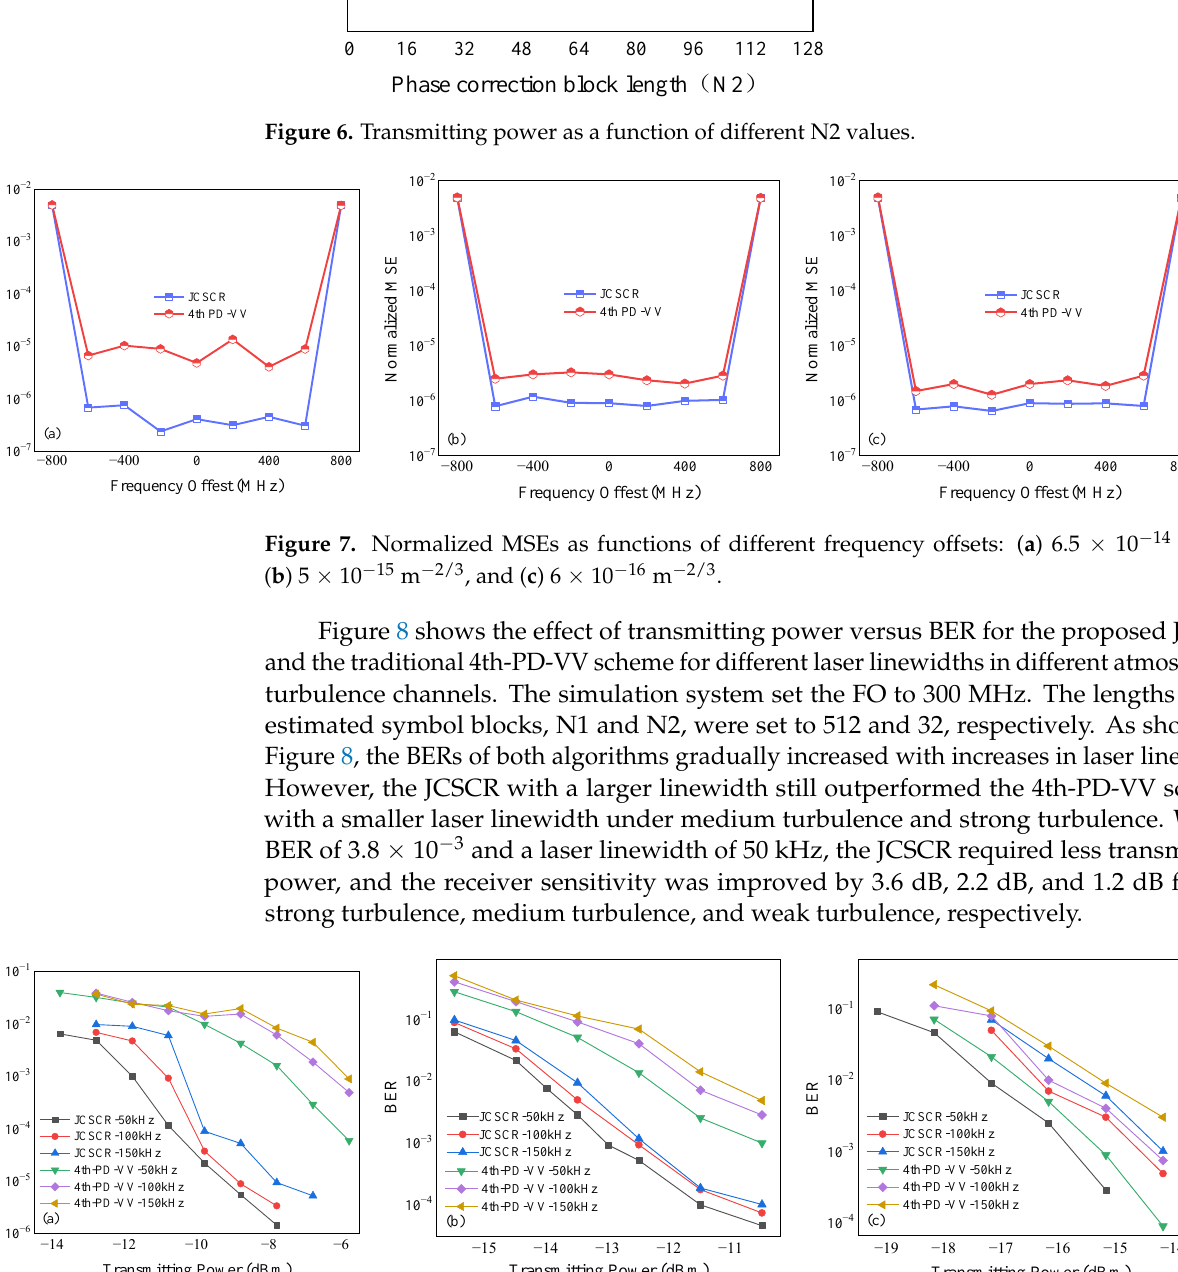
Figure 8. BER as a function of the transmitting power at different linewidths: ( a ) 6.5 × 10 − 14 m − 2/3 , ( b ) 5 × 10 − 15 m − 2/3 , and ( c ) 6 × 10 − 16 m − 2/3